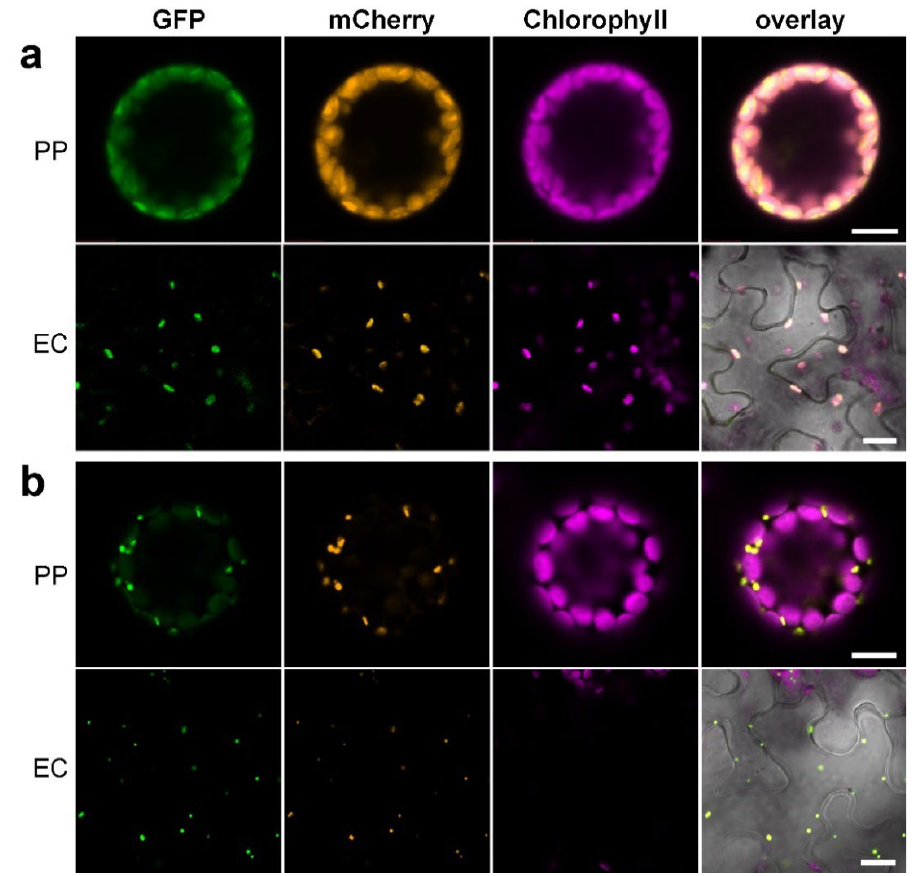
Figure 5. Colocalization of AOC2 ( a ) and OPR3 ( b ) with the respective markers. ( a ) The coding sequence of AOC2 was cloned into the final OM (pAGH1103 and pAGH1121), which led to C-terminal fusion of AOC2 with GFP and contained the marker for plastids (Rubisco (1–79)–mCherry). ( b ) The coding sequence of OPR3 was cloned into the final OM (pAGH1130 and pAGH1136), which led to N-terminal fusion of OPR3 with GFP and contained the marker for peroxisomes (mCherry–SKL). Fluorescence of the target protein fused to GFP is shown in green, whereas the OM (mCherry) is shown in orange. The autofluorescence of chloroplasts is depicted in magenta. The overlay shows all three channels; for epidermal cells, the bright-field image was included. Note the overlay of GFP and mCherry indicates colocalization of the target protein with the OM. PP—protoplast, EC—epidermal cell. Bars represent 10 µm for protoplasts and 20 µm for epidermal cells.